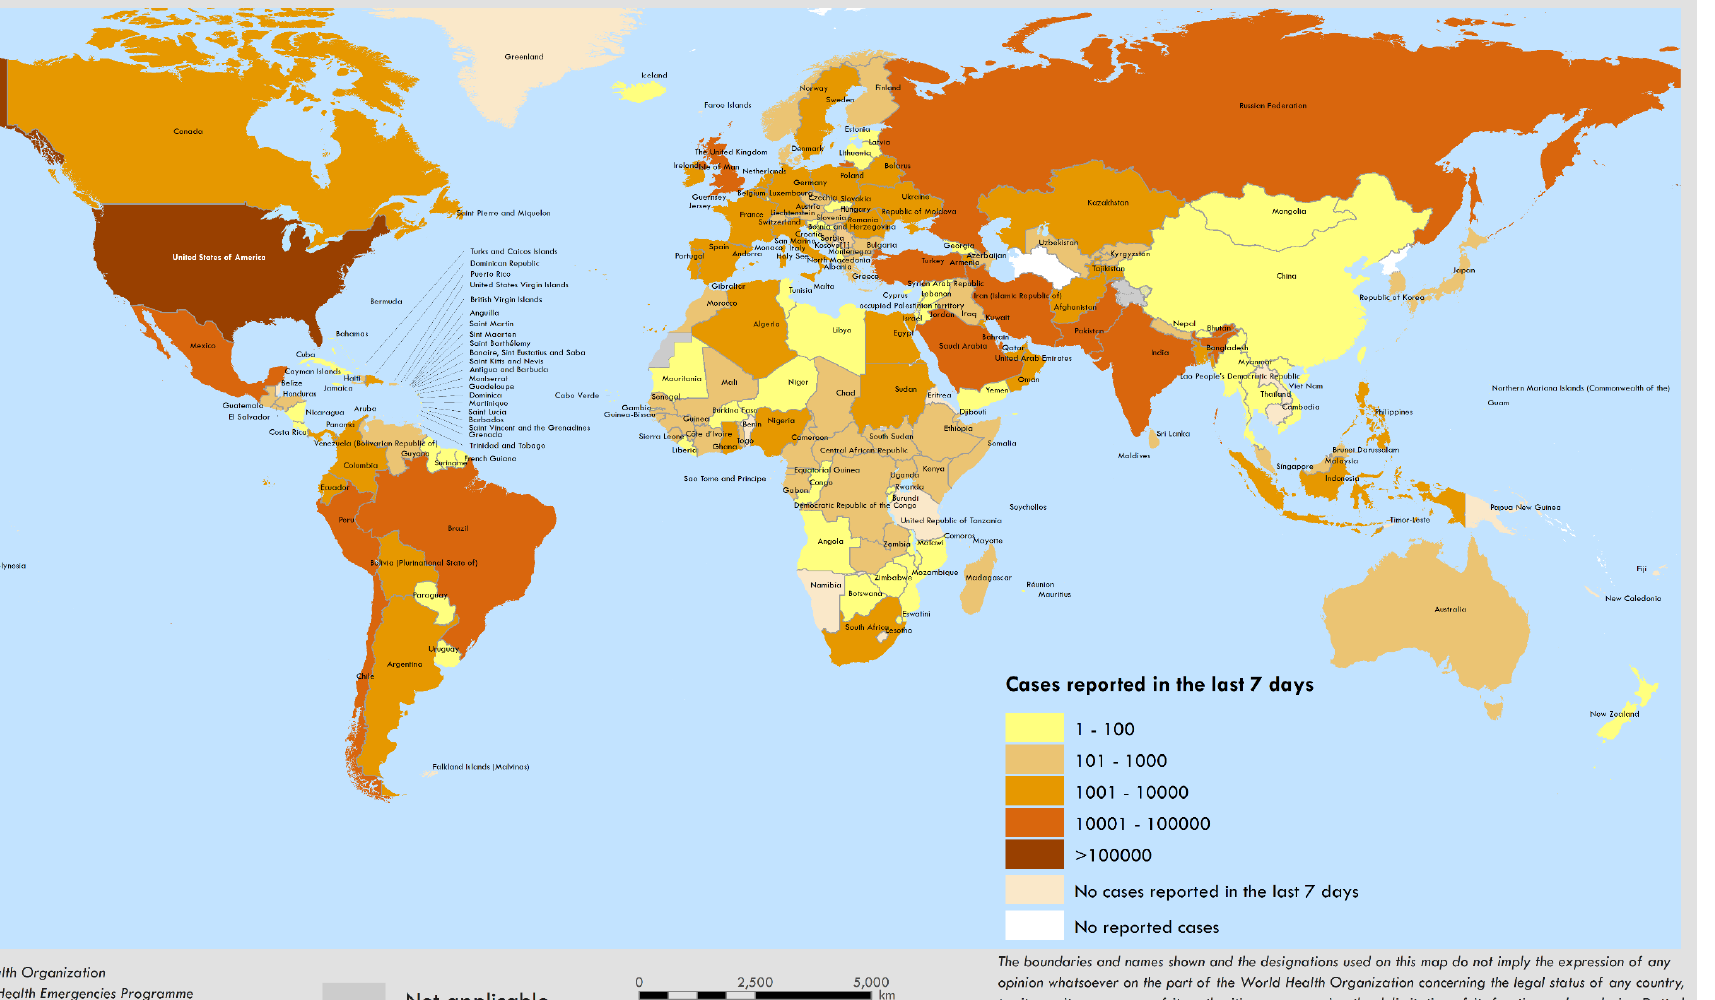
Figure 1. Number of confirmed COVID-19 cases reported in the last seven days by country, territory or area, 13 May to 19 May**